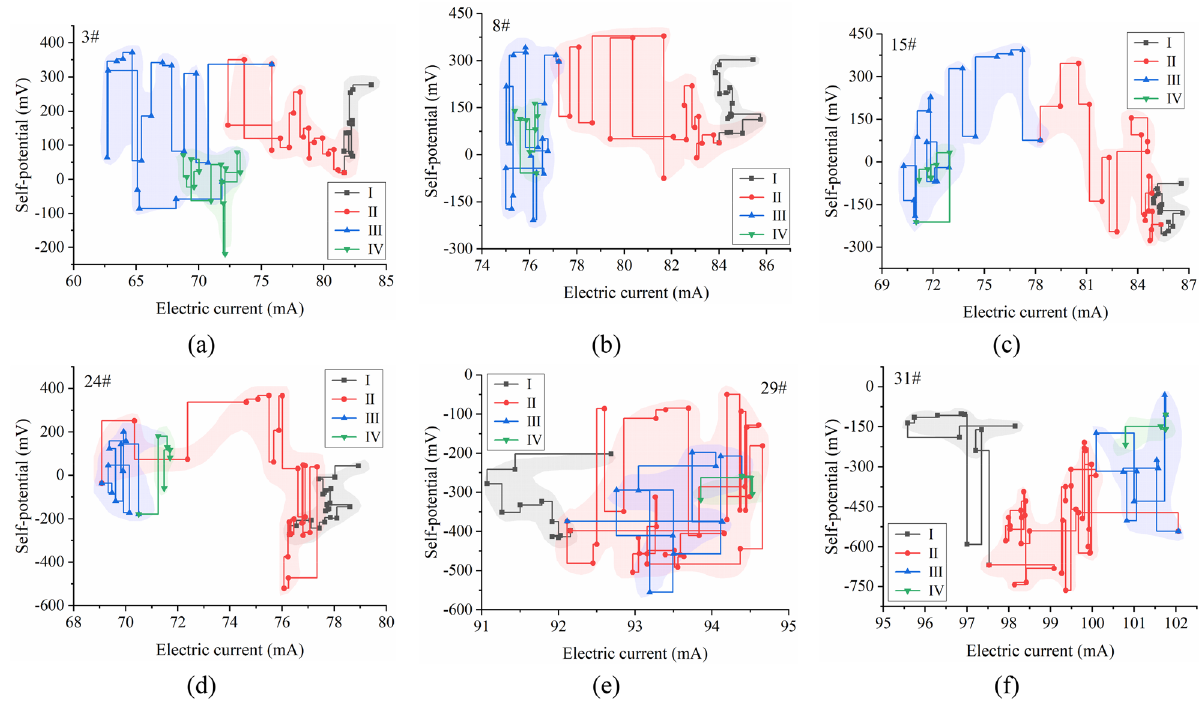
Figure 12. Distribution of the trajectory of the geoelectric field data at measurement points.